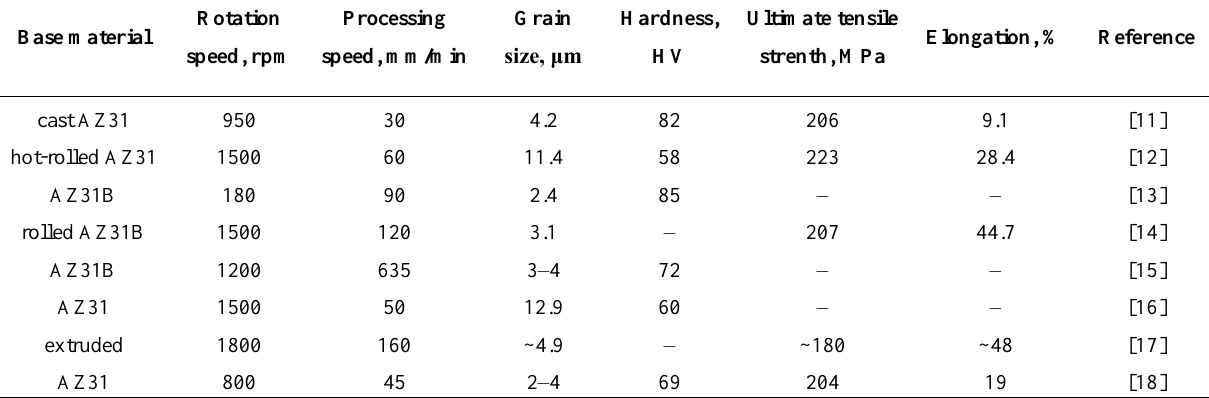
Table 1. Microstructure and mechanical properties of AZ31 magnesium alloys prepared by friction stir processing